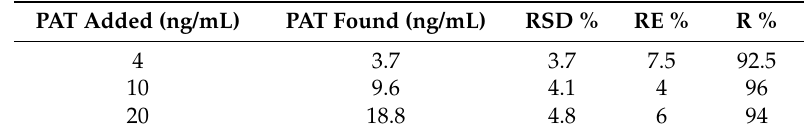
Table 1. Recovery percentages obtained with designed electrochemical aptasensor for PAT monitoring in apple juice. PAT Added (ng/mL) PAT Found (ng/mL) RSD % RE % R % 4 3.7 3.7